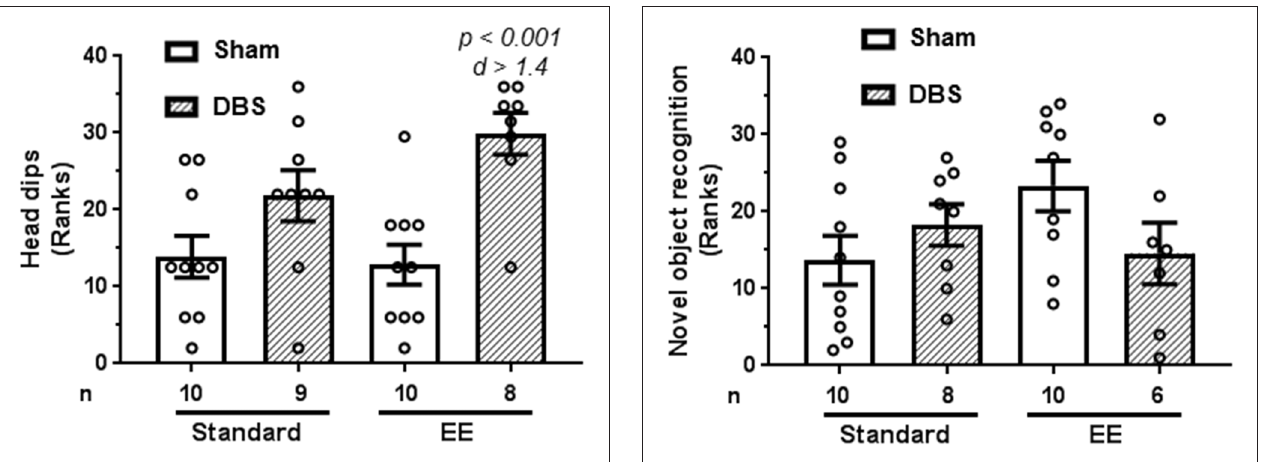
FIGURE 4 | Effects of DBS on short-term memory (90 min) in presence or absence of EE. Object recognition was measured as percentage time spent near novel object relative to total time spent with novel and familiar object (chance = 50%). This endpoint was rank-transformed for the illustration. Mean and SEM, along with individual rank of animals in each group, are depicted. Number of animals ( n ) is also